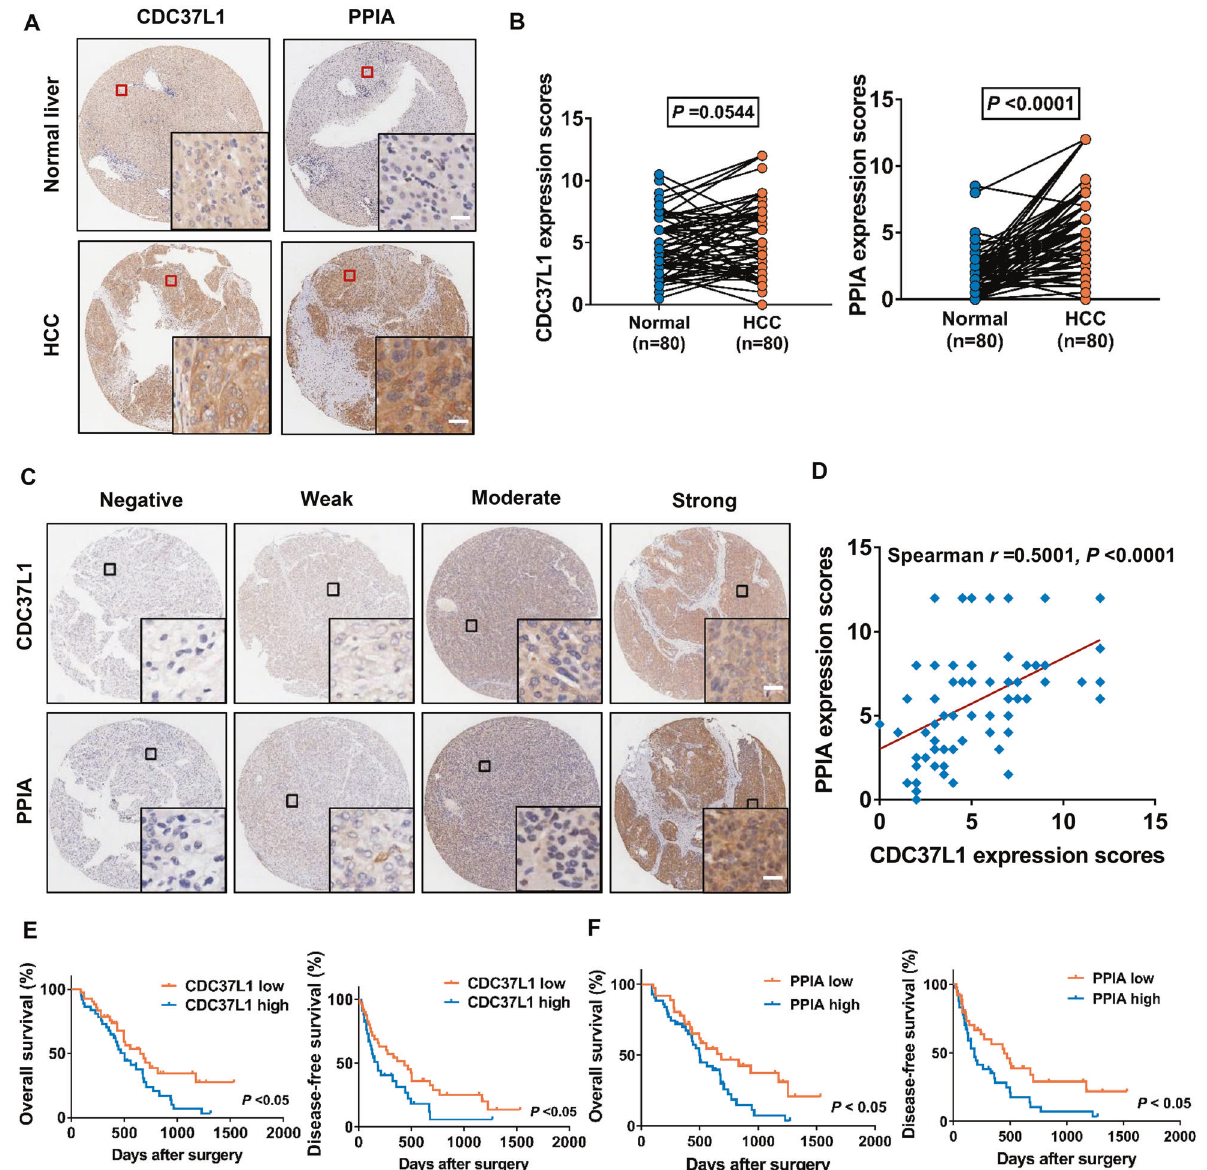
Fig. 6 CDC37L1 and PPIA predict poor prognosis of HCC patients subjected to sorafenib therapy. A Representative images of IHC staining of CDC37L1 and PPIA in normal and HCC tumor tissues. B Quanti fi cation of CDC37L1 and PPIA protein levels in 80 pairs of normal and HCC tissues ( n = 80, paired t test, two-tailed). C Representative images of IHC staining of CDC37L1 and PPIA in consecutive HCC tissues. D The expression correlation of CDC37L1 and PPIA in ( C ) was analyzed. E , F Overall survival and disease-free survival of CDC37L1 or PPIA-high and − low group patients ( n = 80, log-rank test). Scale bars: 25 μ